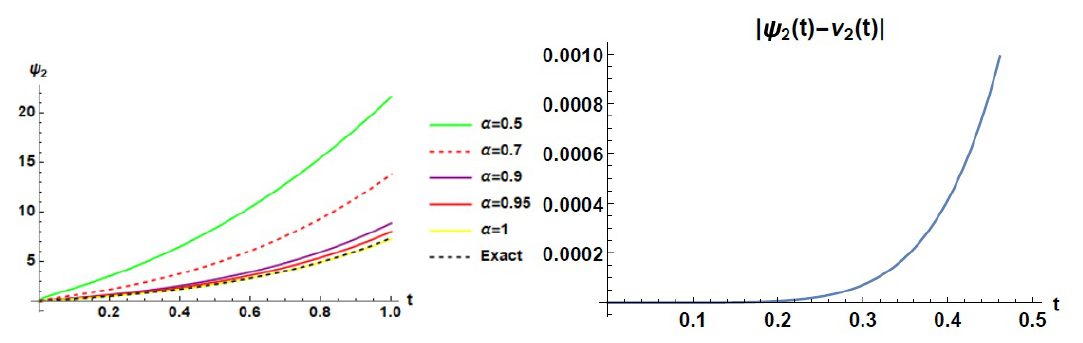
Figure 4: Exact, profile approximate solutions and absolute error regarding ν 2 of Example 2.